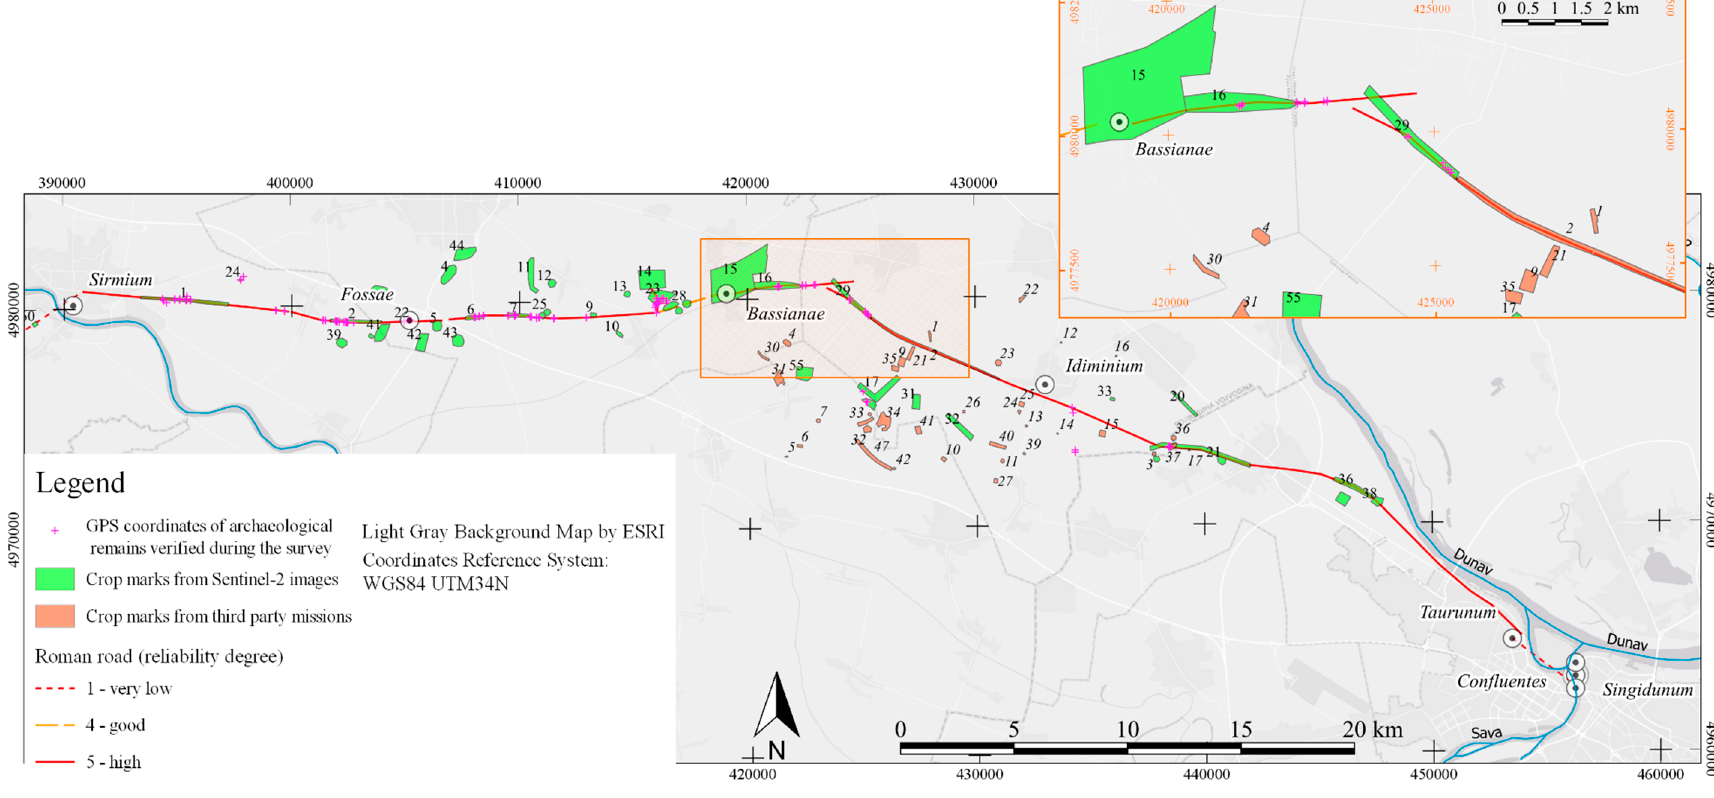
Figure 9. Map representing the results obtained during the archaeological survey in Srem. In the focus is the segment of the Roman road between Bassianae and Singidunum , mapped for the first time within the RecRoad project.